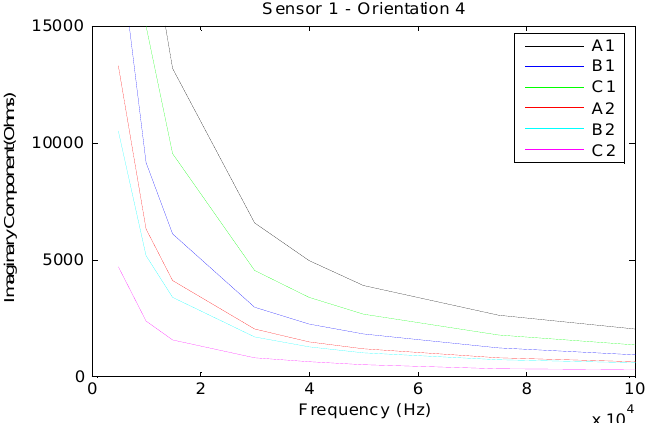
Figure 39. Sensor 1 characteristics for pork belly samples at orientation